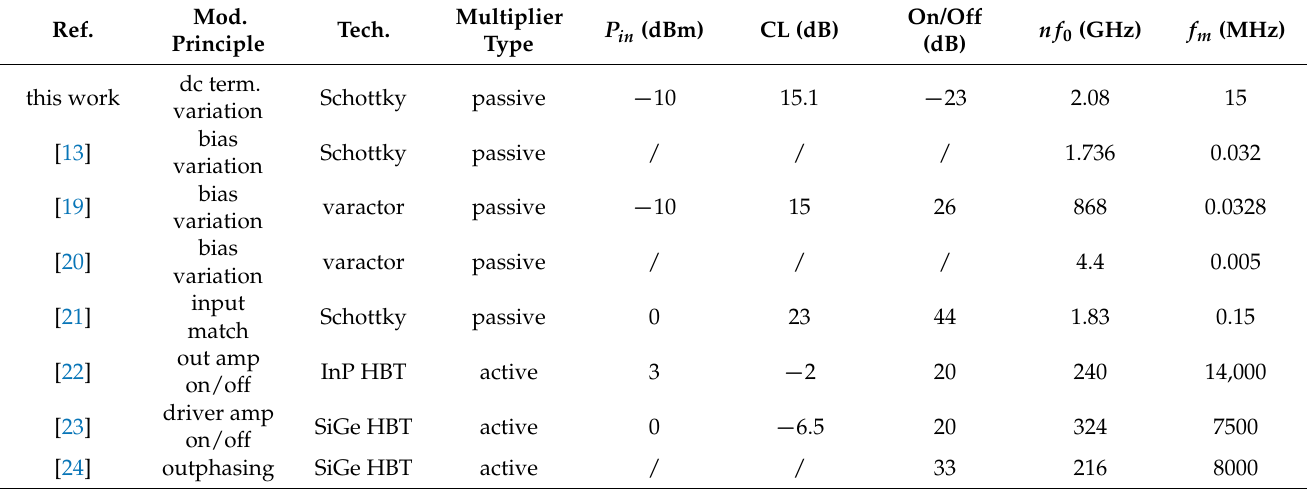
Table 1. Comparison with SoA modulation-capable frequency